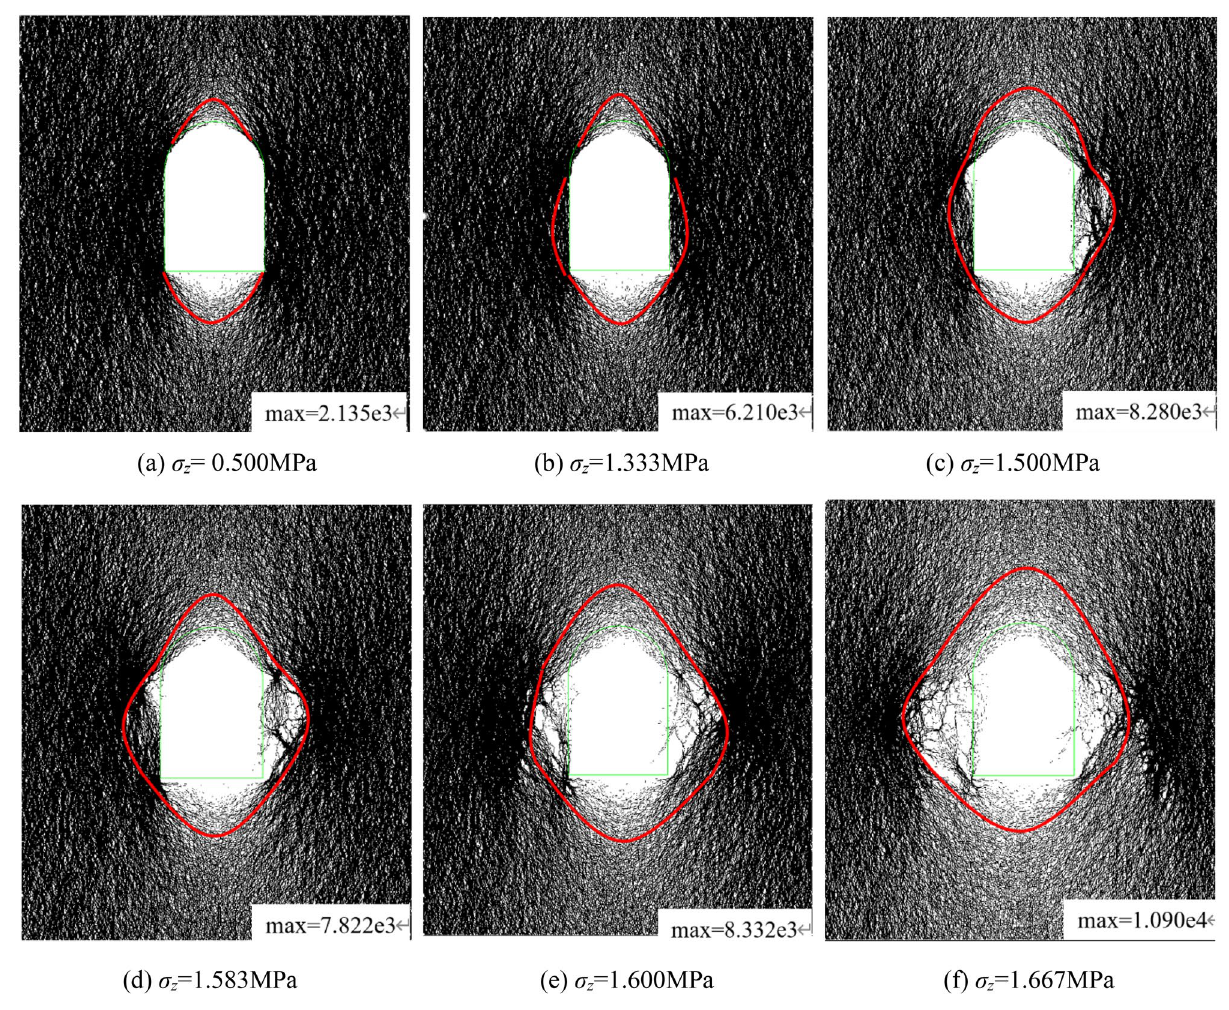
Figure 17. Force chain distribution during the loading failure testing.